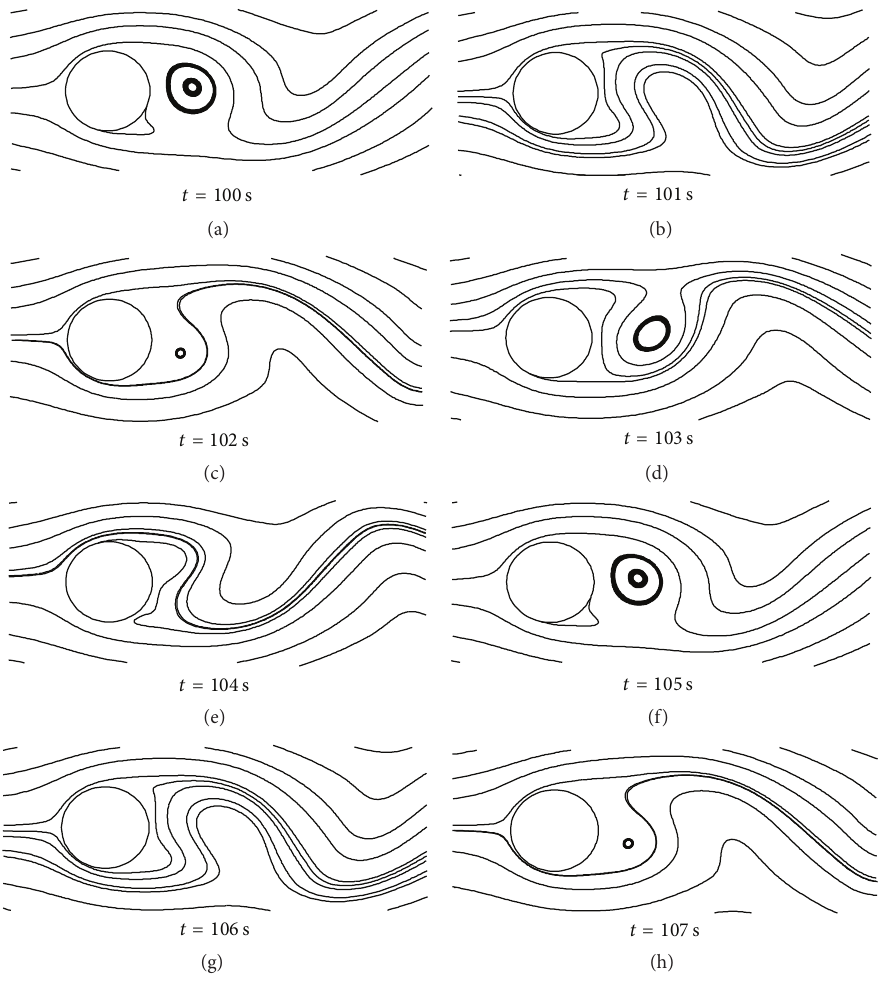
Figure 10: Time-dependent streamline contours for Re =